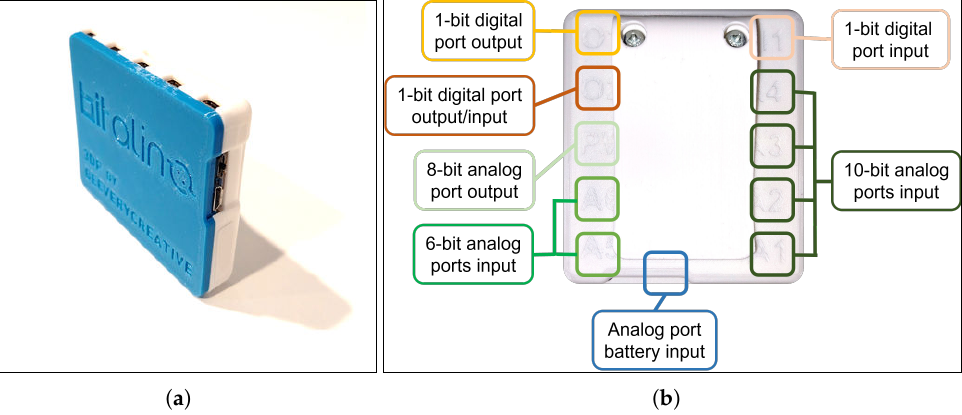
Figure 4. BITalino Core BT board: ( a ) assembled board for measuring bio-signals; ( b ) device ports where sensors and actuators can be